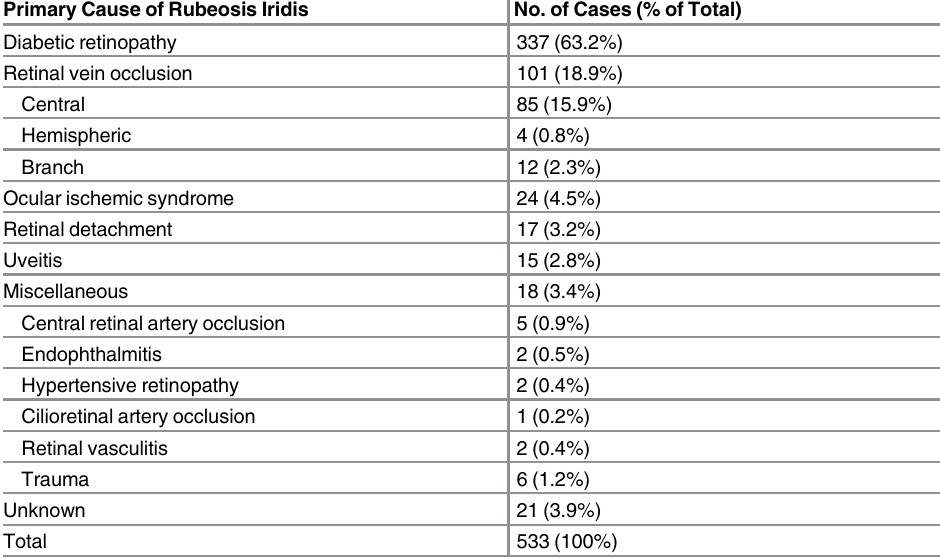
Table 1. Presumed etiologic factors associated with rubeosis